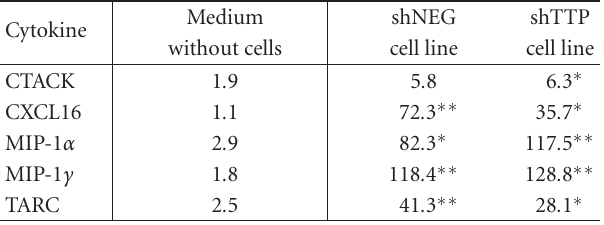
Table 2: Cytokines secreted spontaneously by shNEG and shTTP cell lines. Arbitrary units compared to positive controls (100) are SEM ( n = presented. Mean (cid:0)